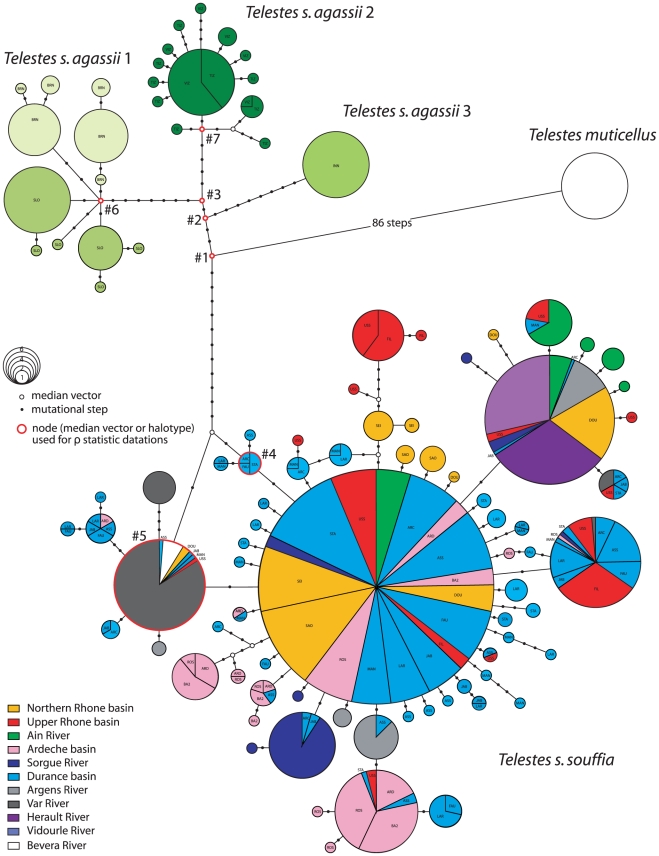
Median-Joining network of the T. souffia mitochondrial haplotypes.Population samples ID detailed in haplotypes charts when necessary.